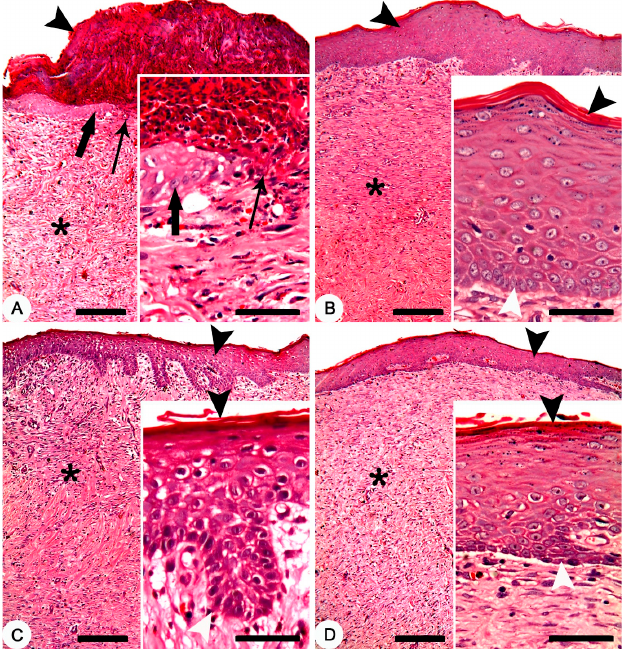
Figure 6. Skin, New Zealand rabbit. Histopathology of thermally induced skin burns after 28 days of treatment. ( A ) non ‐ treated group showing crusts on the surface of the skin (arrowhead), denuded skin surface from the epidermal layer (thin arrow) and a granulation tissue (asterisk). Inset showing crawling of the epidermal cells (thick arrow) over the granulation tissues of the denuded skin (thin arrow). ( B ) composite cream treated group showing complete epidermal layer (arrowhead) covering a granulation tissue (asterisk). Inset showing mature and complete epidermal layers between the stratum corneum (black arrowhead) and stratum germinativum (white arrowhead). ( C ) MEBO ® cream treated group showing complete epidermal layer (arrowhead) covering a granulation tissue (asterisk). Inset showing complete epidermal layers between a thin stratum corneum (black arrowhead) and stratum germinativum (white arrowhead). ( D ) silver sulfadiazine cream treated group showing complete epidermal layer (arrowhead) covering a granulation tissue (asterisk). Inset showing complete epidermal layers between a thin stratum corneum (black arrowhead) and stratum germinativum (white arrowhead). HE stain; Bars: main figures 200 μ m, Inset 50 μ m.